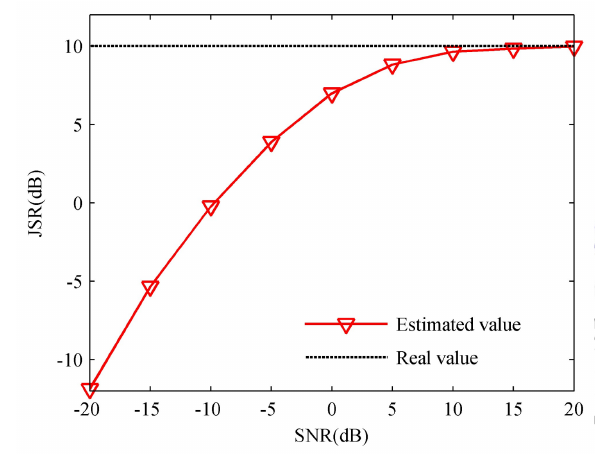
Figure 11. The estimated JSR versus the input of SNR.